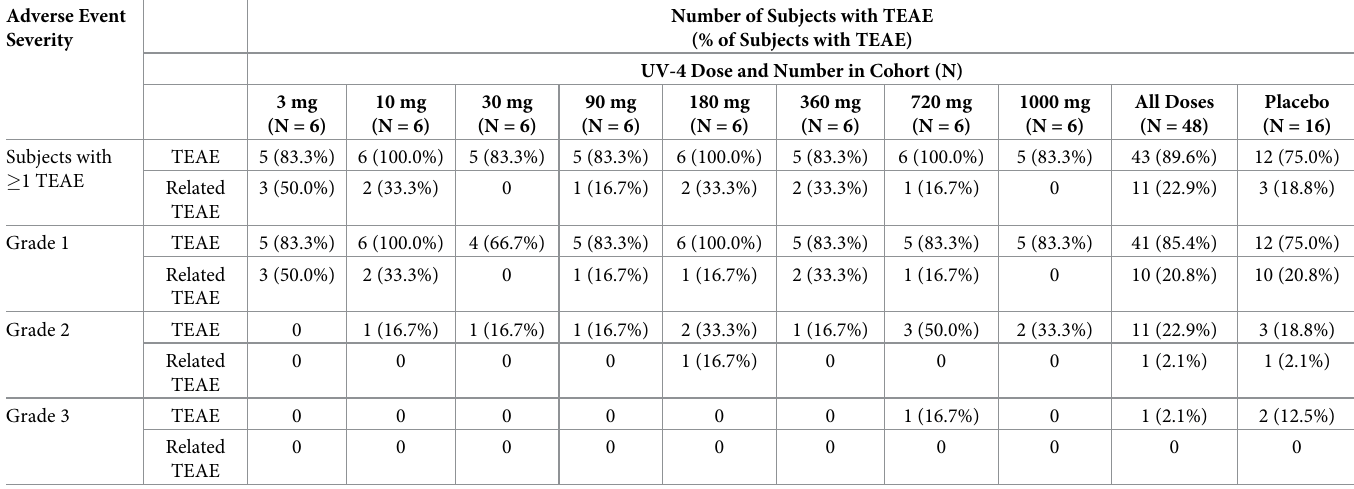
Table 2. Summary of Subjects with Treatment-Emergent Adverse Events by Severity. Adverse Event Severity